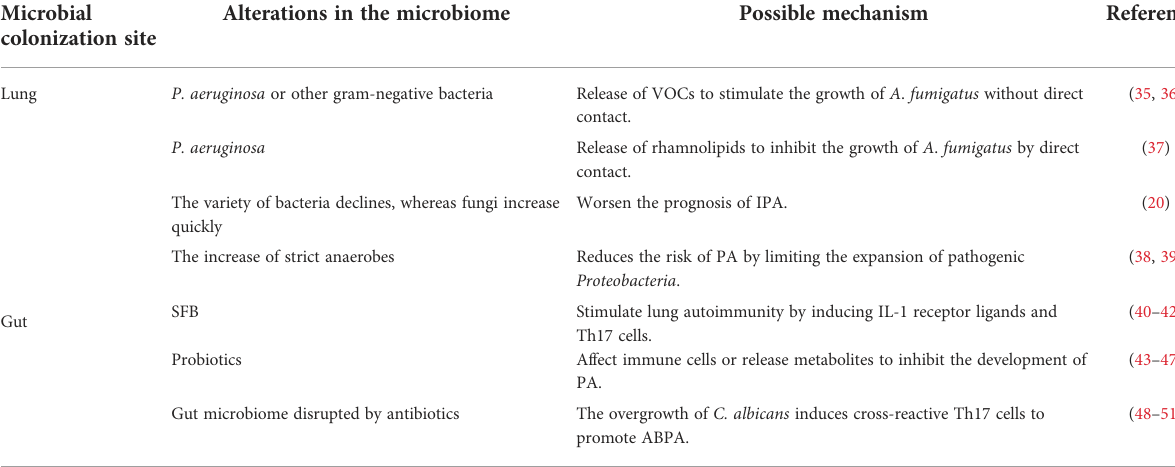
TABLE 1 The possible mechanisms underlying the effects of the lung and gut microbiomes on